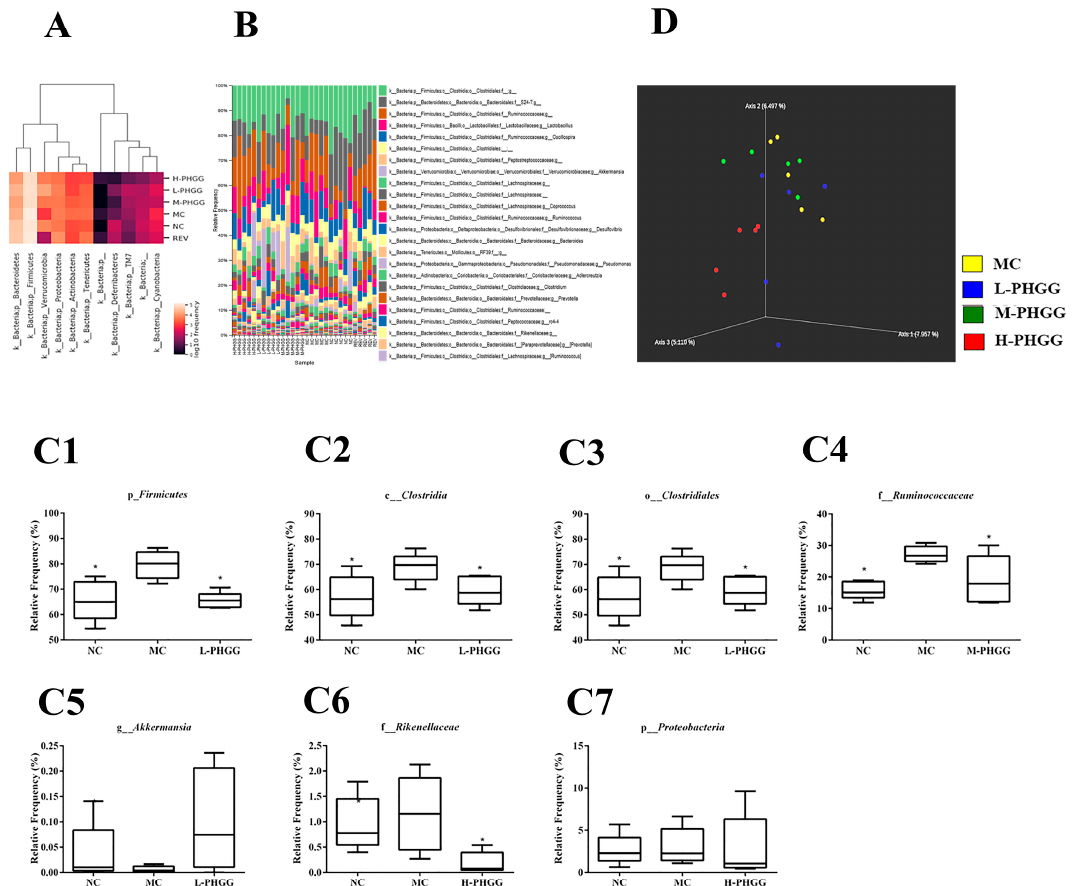
Figure 5. E ff ects of PHGG on the murine gut microbiome based using 16S rDNA sequencing. ( A ) Microbiota bacterial changes at the phylum level for each treatment groups. ( B ) Microbiota relative reference (%) are plotted to the genus taxonomy level for each fecal sample. ( C ) Bacterial population di ff erences among the displayed groups on di ff erent taxonomy levels (p, phylum; c, class; o, order; f, family; g, genus). ( D ) Principle coordinates analysis (PCoA) of the model control and PHGG groups based on the Jaccard distance. Statistical significance between the model control group and the other groups was determined by the Kolmogorov–Smirnov test and Levene’s test for hypotheses of normality and variance homogeneity, followed by Student’s t -test or Mann–Whitney’s U non-parametric test. * p < 0.05 compared with the model control group. NC, normal control (saline); MC, D -gal model control (saline); REV, resveratrol (20 mg/kg/day); L-PHGG, 500 mg/kg/day; M-PHGG, 1000 mg/kg/day; H-PHGG, 1500 mg/kg/day.